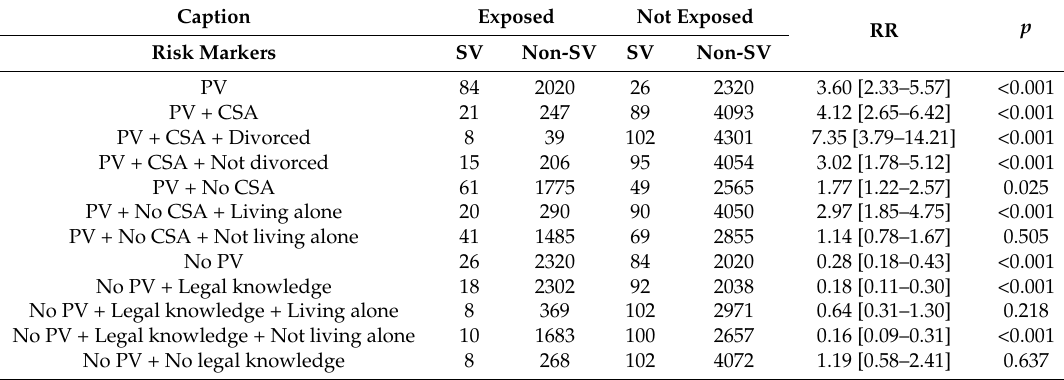
Table 2. Effect sizes (relative risks) in cases of presence and not-presence of the risk markers used as predictors in the C-Tree